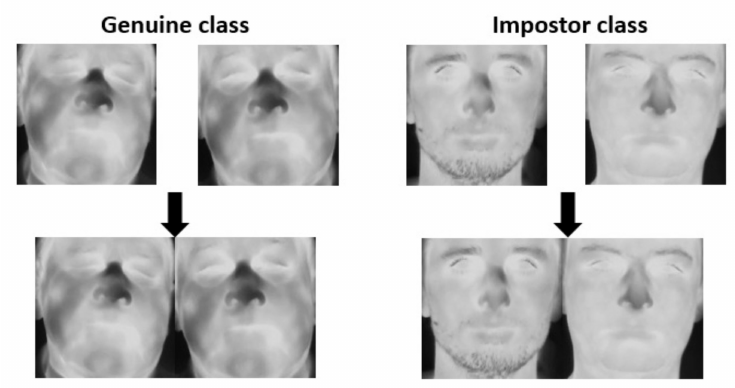
Figure 2. Scheme of combining two images into genuine and impostor classes.